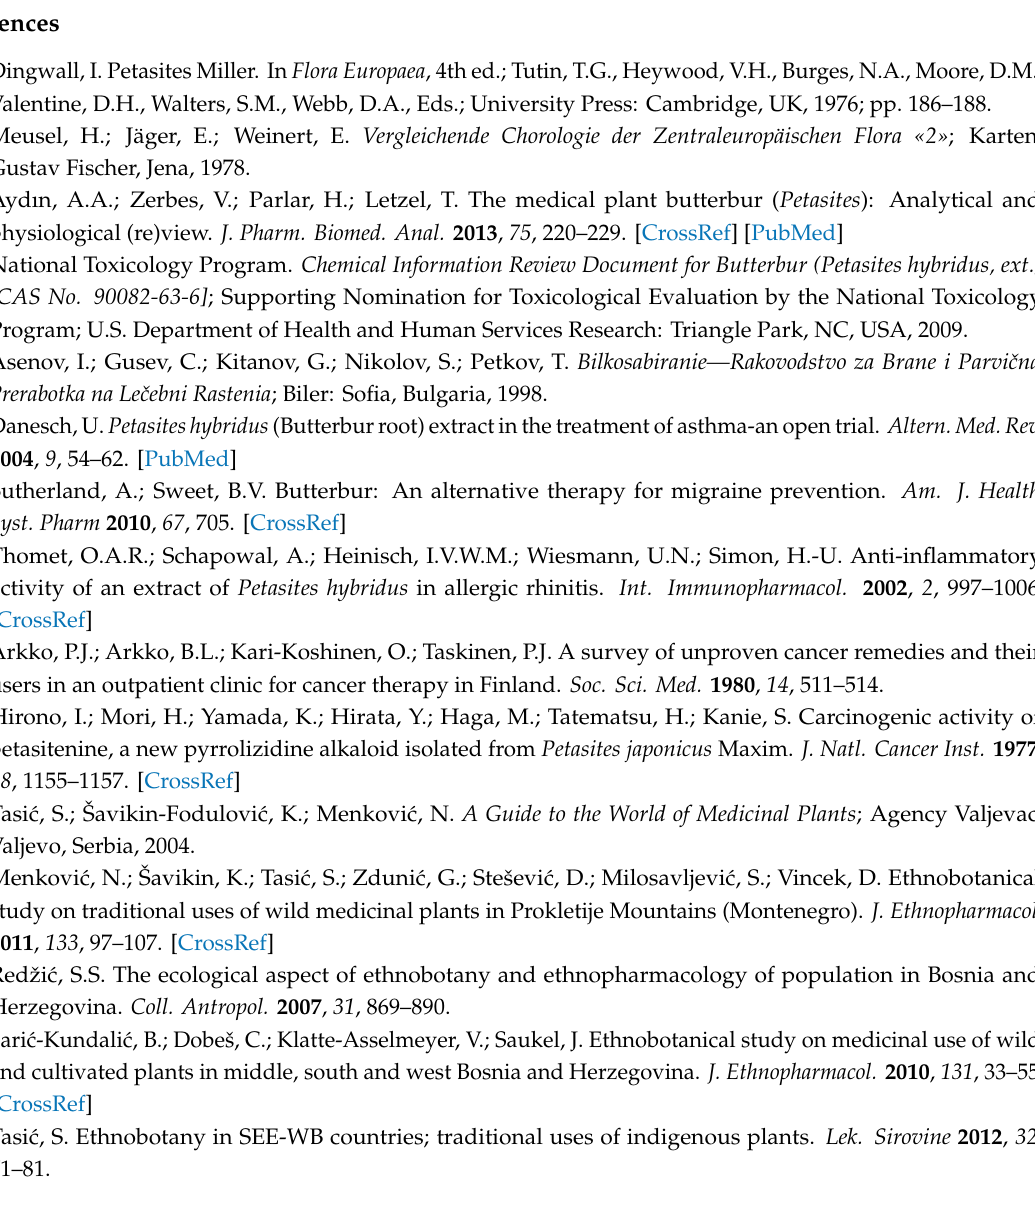
Figure S1. TIC Chromatogram of rhizome essential oil (Numbers above the peaks corresponding to the numbers in Table 1, Figure S2: Extracted spectrum for the compound No. 54, identified as 7-epi- α -Eudesmol, Figure S3: Extracted spectrum for the compound No. 60, identified as Isopetasine, Figure S4: Extracted spectrum for the compound No. 61, identified as